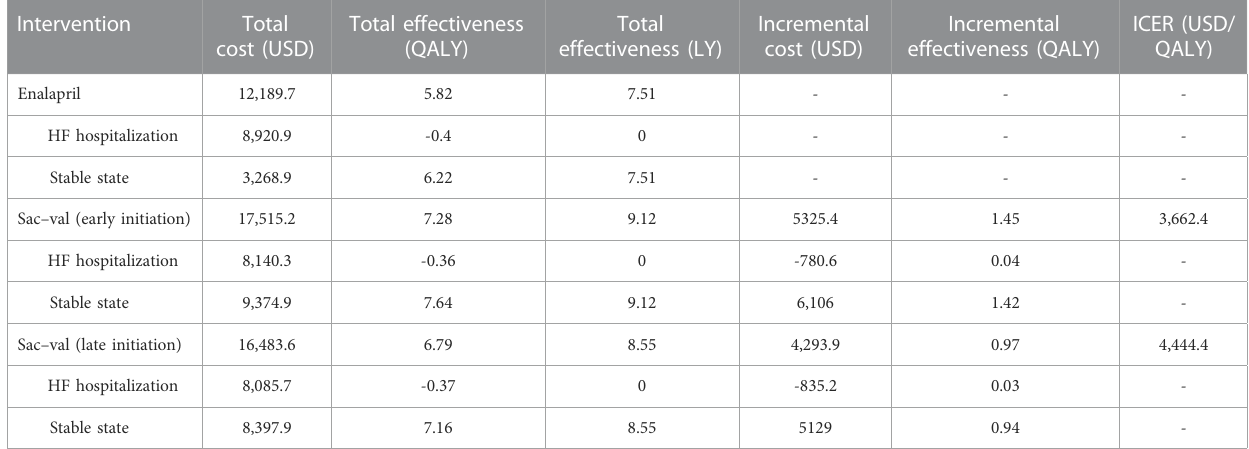
TABLE 3 Base case analysis of sacubitril – valsartan versus enalapril for treatment of acute decompensated heart failure. Intervention Total Total effectiveness Total cost (USD) (QALY) effectiveness (LY)